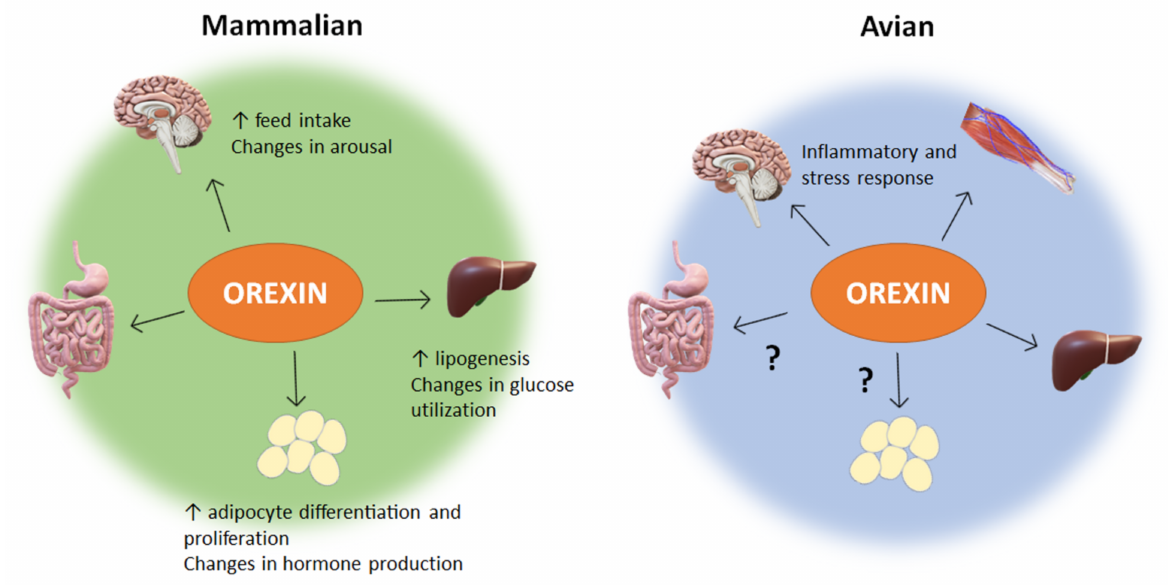
Figure 1. Impacts of orexin within mammalian and avian species. ? means the physiological function of orexin is still unknown or not well defined. In mammalian species of veterinary interest, such as mice, rats, sheep, cats, and dogs, orexin has been proven to be more than a neuropeptide. In addition to its central regulation of feeding behavior and sleep-wake cycles, orexin affects intestinal motility, pancreatic secretions, adipogenic factors, and energy homeostasis. In non-mammalian species such as chicken, research is limited, but shows a role of orexin in the central response to inflammatory and stress stimuli. Additionally, orexin in avian species has a peripheral influence on muscle mitochondrial dynamics and function, as well as hepatic stress response and lipogenic factors. Major gaps exist in our understanding of orexin’s influence on other peripheral tissue in avian species. Taken together, these findings demonstrate a necessity for further research into the diverse and undiscovered peripheral roles orexin plays in animal behavior, metabolism, and stress, particularly in avian